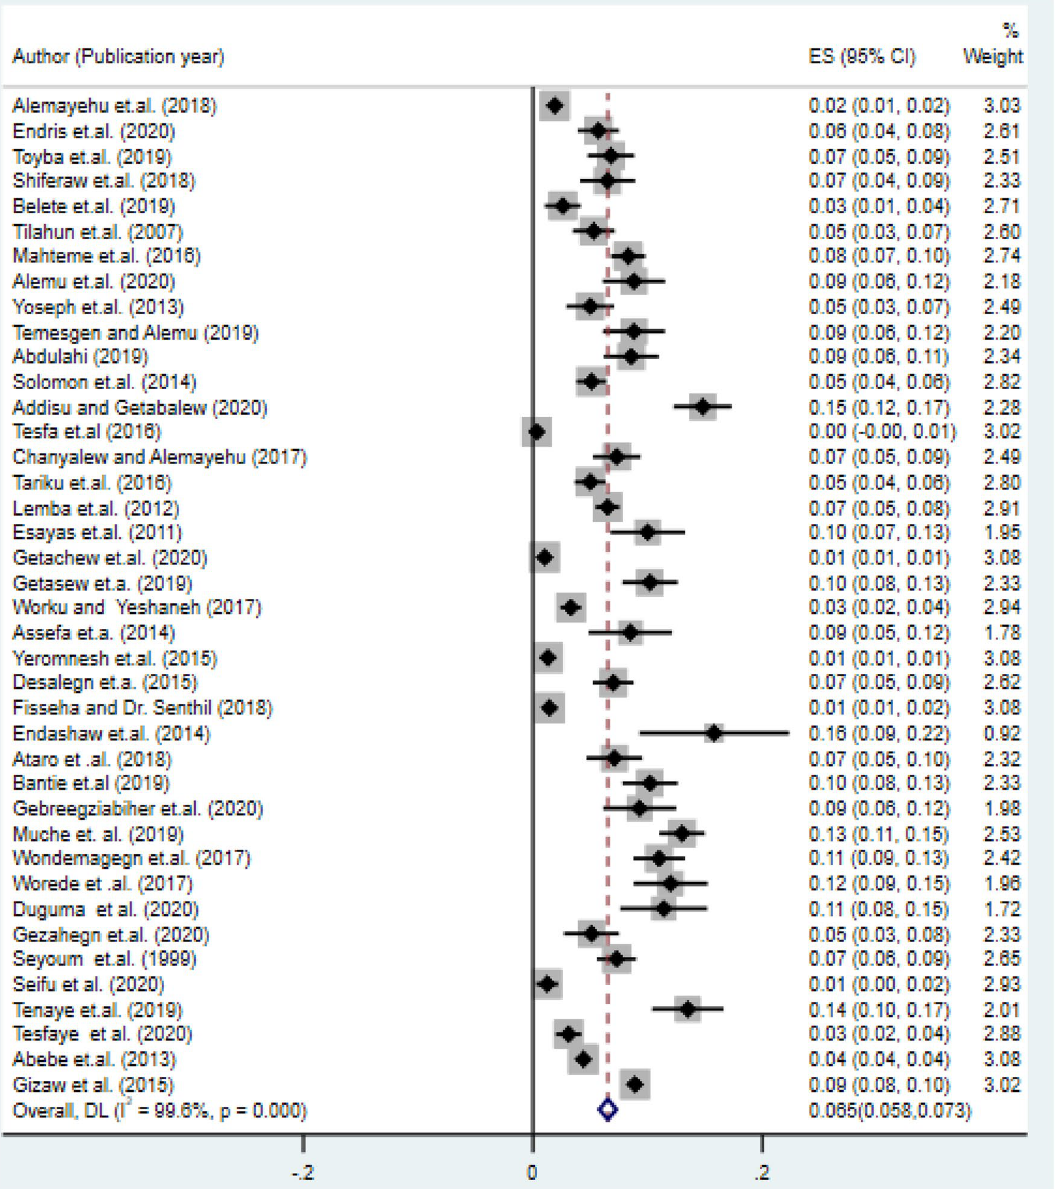
Figure 2. Forest plot of the pooled prevalence of diabetes mellitus in